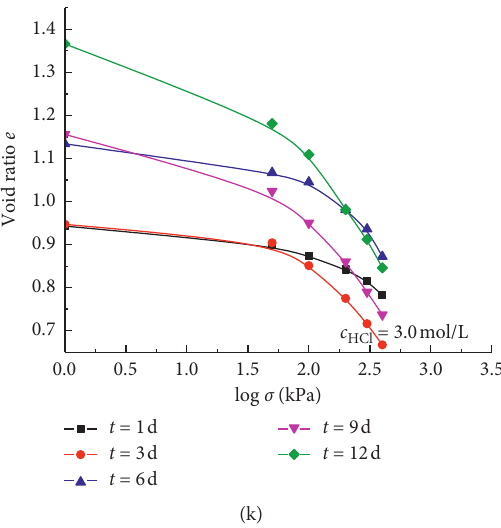
Figure 2: Compression curve e − log σ of different samples. (a) The acid immersion time is 1d and the CCC under different acid con- centrations. (b) The acid immersion time is 3d and the CCC under different acid concentrations. (c) The acid immersion time is 6d and the CCC under different acid concentrations. (d) The acid immersion time is 9d and the CCC under different acid concentrations. (e) The acid immersion time is 12d and the CCC under different acid concentrations. (f) The acid concentration is 0 mol/L (distilled water), and the CCC under different acid immersion time. (g) The acid concentration is 0.1mol/L, and the CCC under different acid immersion time. (h) The acid concentration is 0.5mol/L, and the CCC under different acid immersion time. (i) The acid concentration is 1.0mol/L, and the CCC under different acid immersion time. (j) The acid concentration is 2.0 mol/L, and the CCC under different acid immersion time. (k) The acid concentration is 3.0mol/L, and the CCC under different acid immersion time. Table 2: Compression index C c of loess samples under different acid erosion concentrations and times. c HCl (mol · L − 1